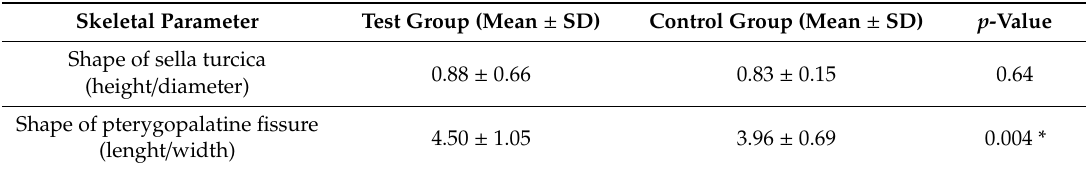
Table 4. Descriptive statistics and results for the shape of sella turcica and of pterygopalatine fissure in the two